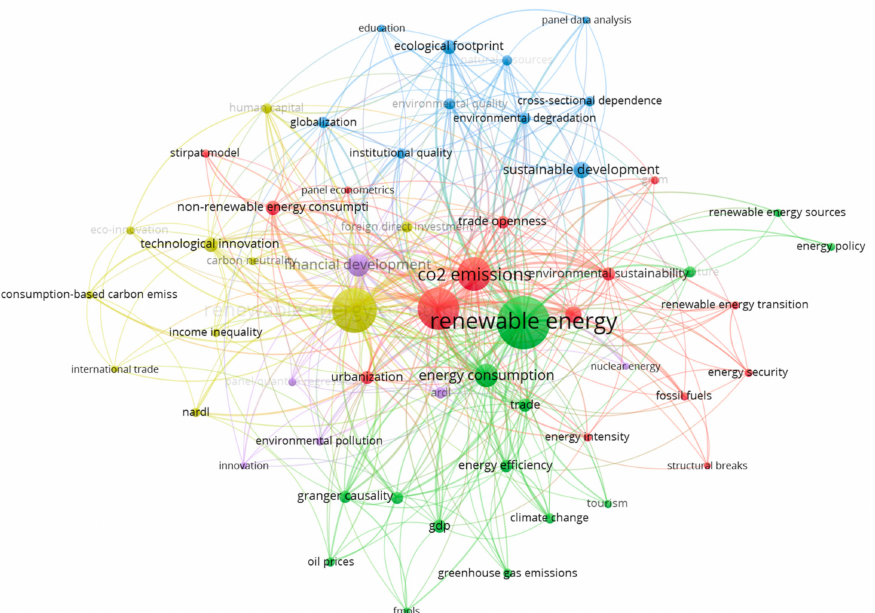
Figure 5. The network map of bibliometric analysis concerning renewable energy consumption (based on the Scopus data, October 2021).